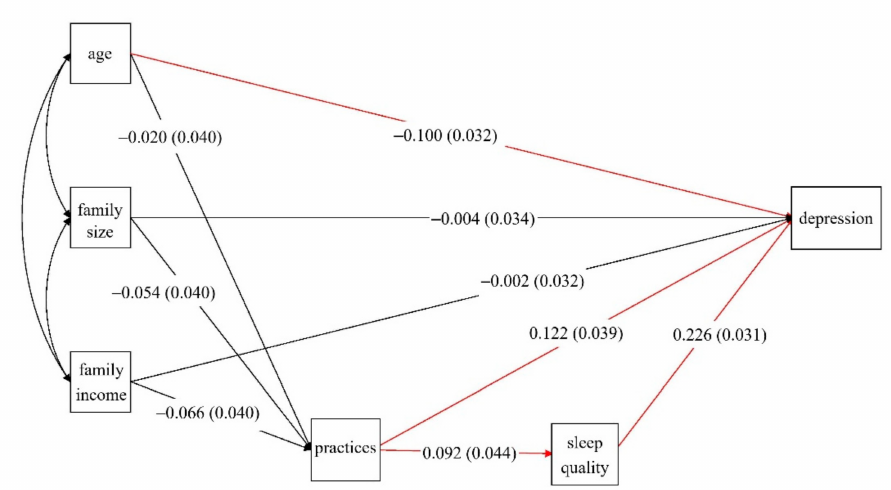
Figure 3. The pathways among postpartum practices and postpartum depression. The standardized effects ( p values) are presented, and the red lines indicate the associations with